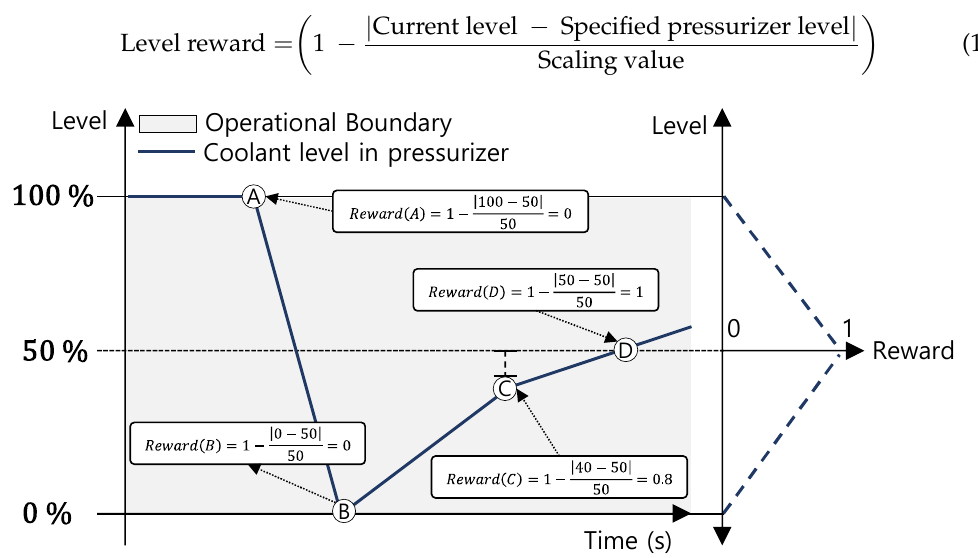
Figure 6. Level reward algorithm for achieving operational goals.